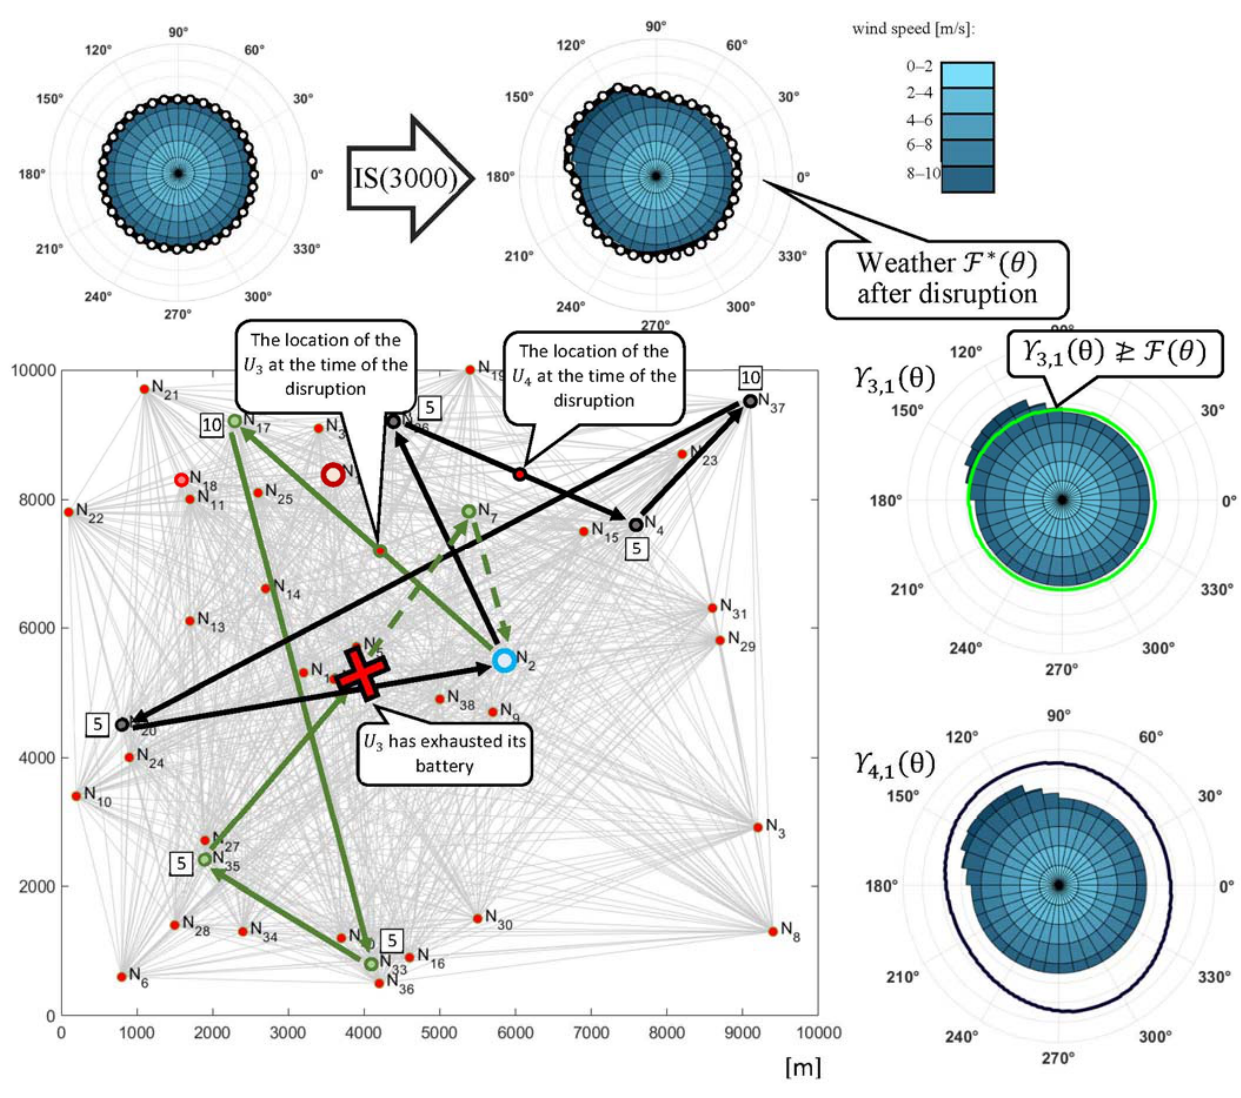
Figure 3. Sub-mission 2 S after changed weather conditions: the wind speed increased to vw = 11 m Figure 3. Sub ‐ mission 𝑆 (cid:2870) after changed weather conditions: the wind speed increased to 𝑣𝑤 (cid:3404) 11 (cid:3040) θ = 110 ◦ –130 ◦ of 𝜃 (cid:3404) 110°–130° .